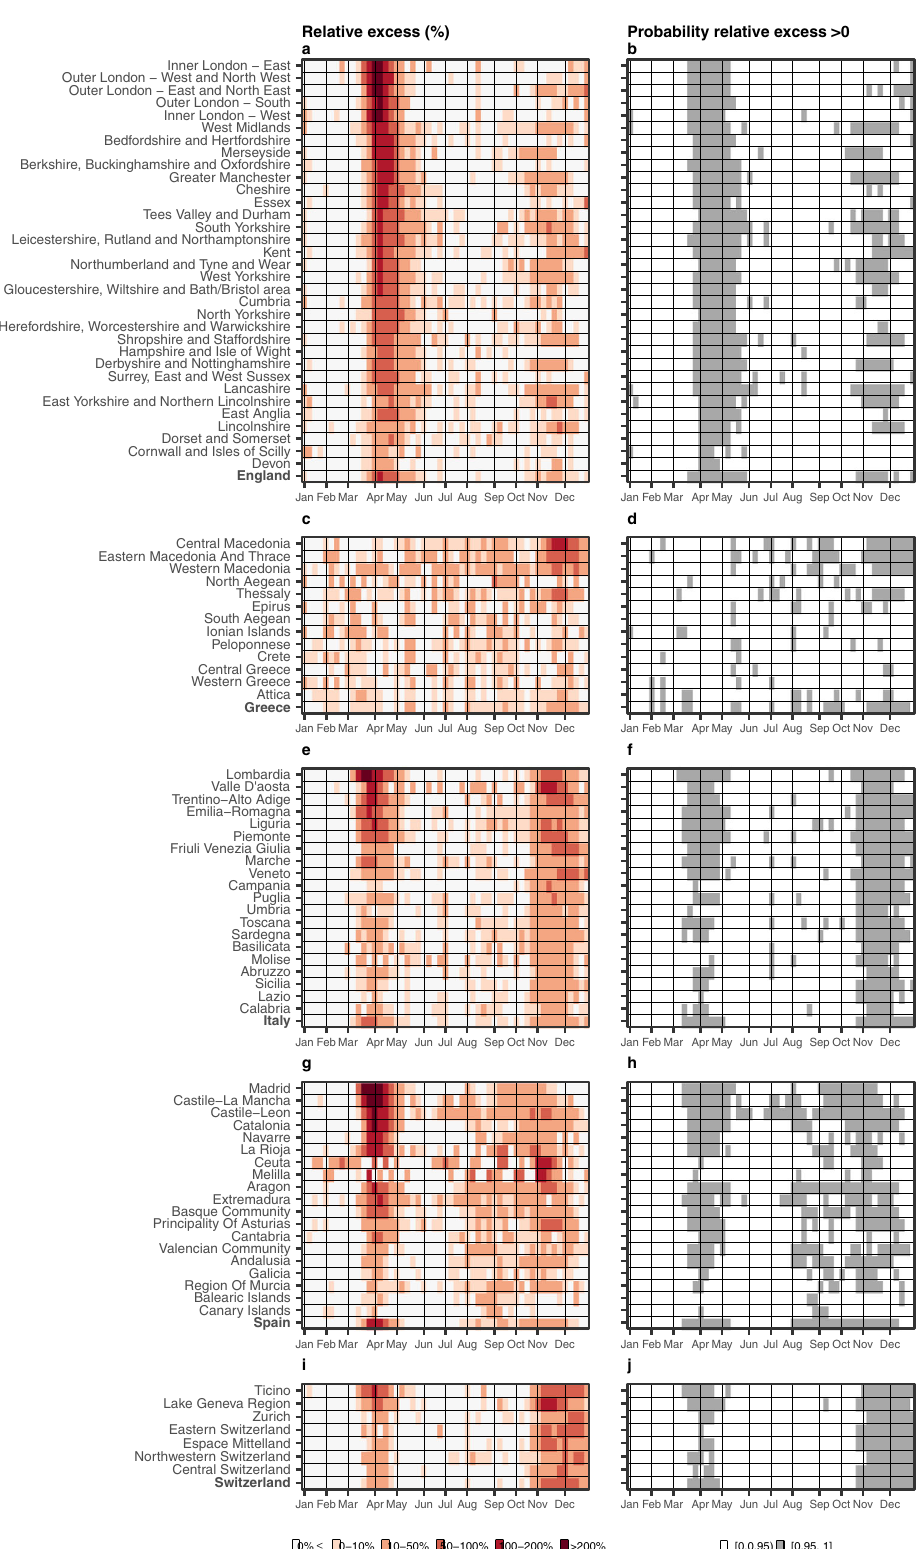
socio-economic characteristics, including age structure, ethnicity, level of deprivation, and environmental factors 14 . Further, the timeframe of non-pharmaceutical interventions in countries and regions and the resilience and capacity of health care systems have played a role 7 . The mobility of populations across borders and between regions and the timeliness of lockdowns have